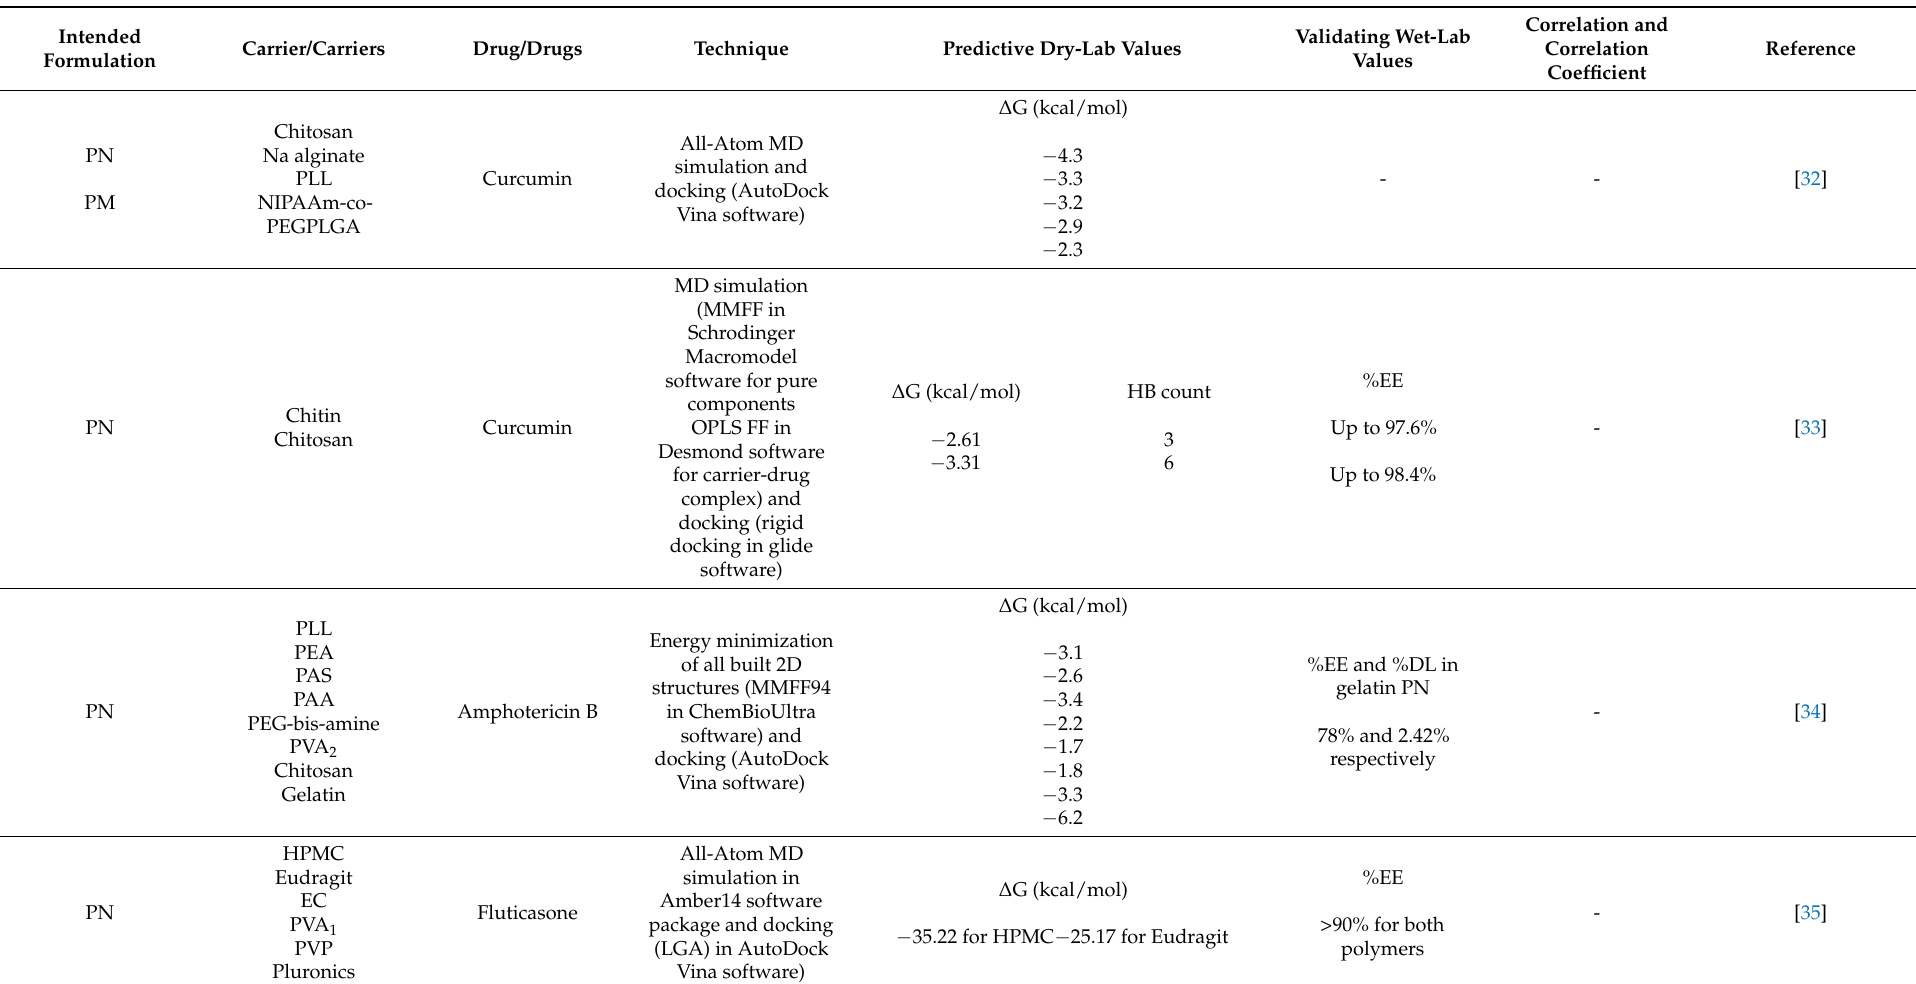
Table 3. Applications of molecular dynamic simulations coupled with docking techniques for modeling drug payload in different lipid and polymeric nanocarriers and their